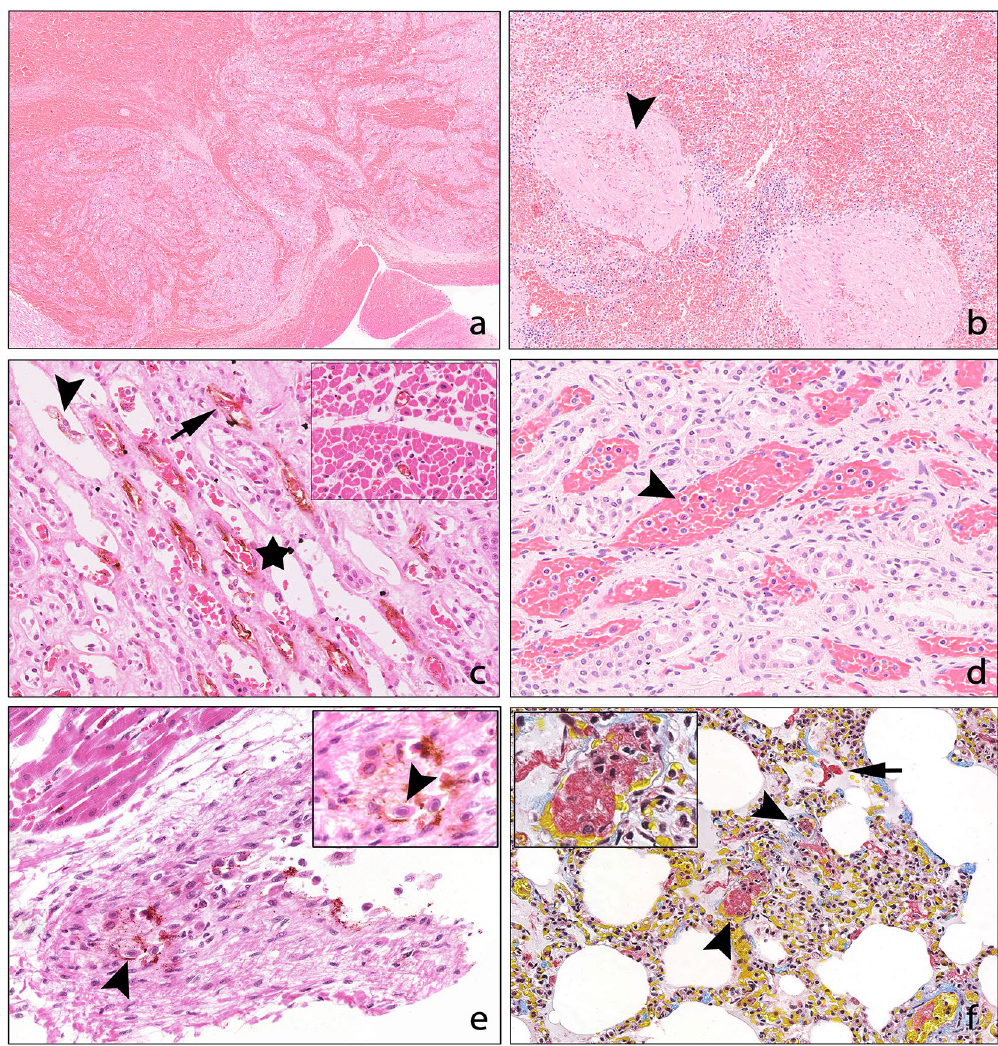
Figure 2. Representative histologic lesions from Asian elephant endotheliotropic herpesvirus-haemorrhagic disease fatalities. ( a ) Heart, haematoxylin and eosin (HE) × 4. Extensive acute haemorrhages expanding subepi- and subendocardial space and widely efface the myocardium. ( b ) Spleen, HE, × 10. Severe parenchymal congestion and haemorrhages and mild trabecular haemorrhages (arrowhead). ( c ) Kidney, von Willebrand factor immunohistochemistry (vWf, brown colouration) with HE counterstain, × 15. Small vessels of the renal medulla exhibit widespread endothelial cell damage. Endothelial cells are variably swollen (arrow), with irregular staining patterns, separation and oedema (star) and sloughed off endothelial cells multifocally accumulate within the vascular lumen (arrowhead). Inset: Control, heart, von Willebrand factor immunohistochemistry with H&E, × 40. Uniform endothelial cells line vessel walls with regular immuolabelling for vWf. ( d ) Kidney, HE, × 20. Diffuse vascular congestion and leukocytostasis (arrowhead). ( e ) Heart, von Willebrand factor immunohistochemistry with HE, × 20. Viral inclusion bodies (arrow head) present within degenerating endothelial cells of a large vessel in a case of EEHV-1A and -4 co-infection. Inset: Intranuclear inclusion bodies (arrow head) magnified, × 40. ( f ) Lung, Martius, scarlet and blue, × 10. Multifocal intravascular fibrin thrombi (arrowheads) fibrin deposits within alveolar spaces (arrow). Inset: Capillary fibrin thrombus magnified, ×